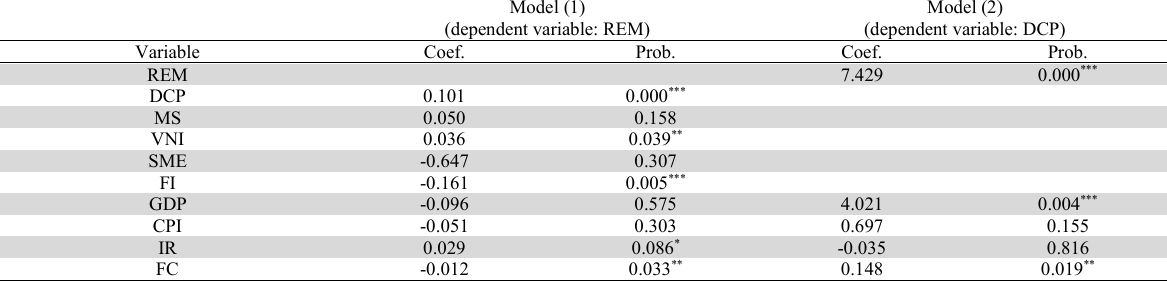
Model (1) (dependent variable: REM)